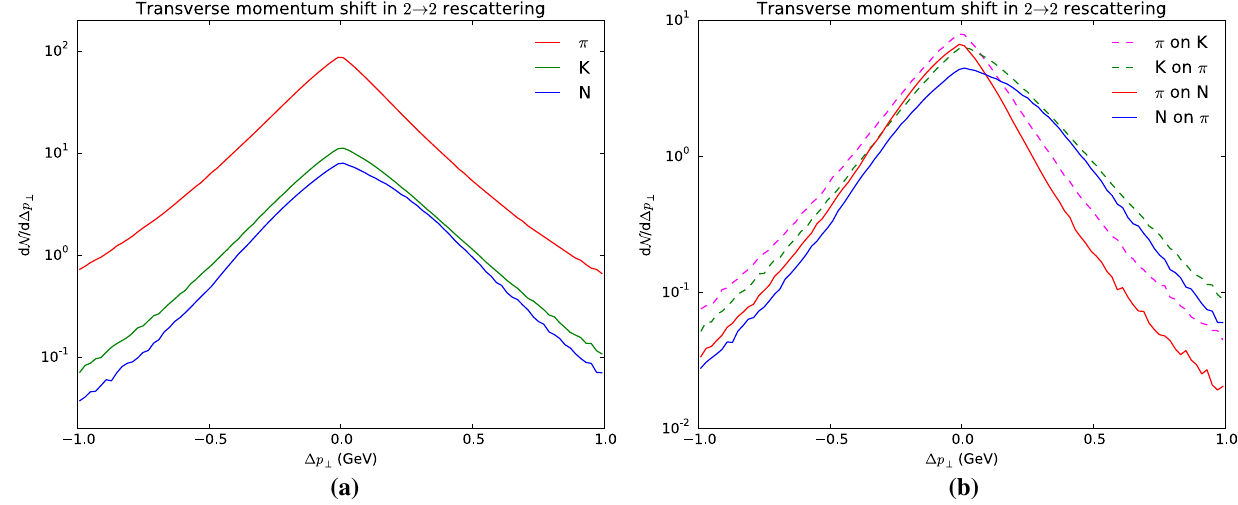
Fig. 17 Shift of transverse momentum by 2 → 2 elastic or resonant processes, where positive numbers correspond to an increased p ⊥ in the collision. a Inclusive shifts for π , K and N (including antiparticles). b Shifts in K π → K π and N π → N π